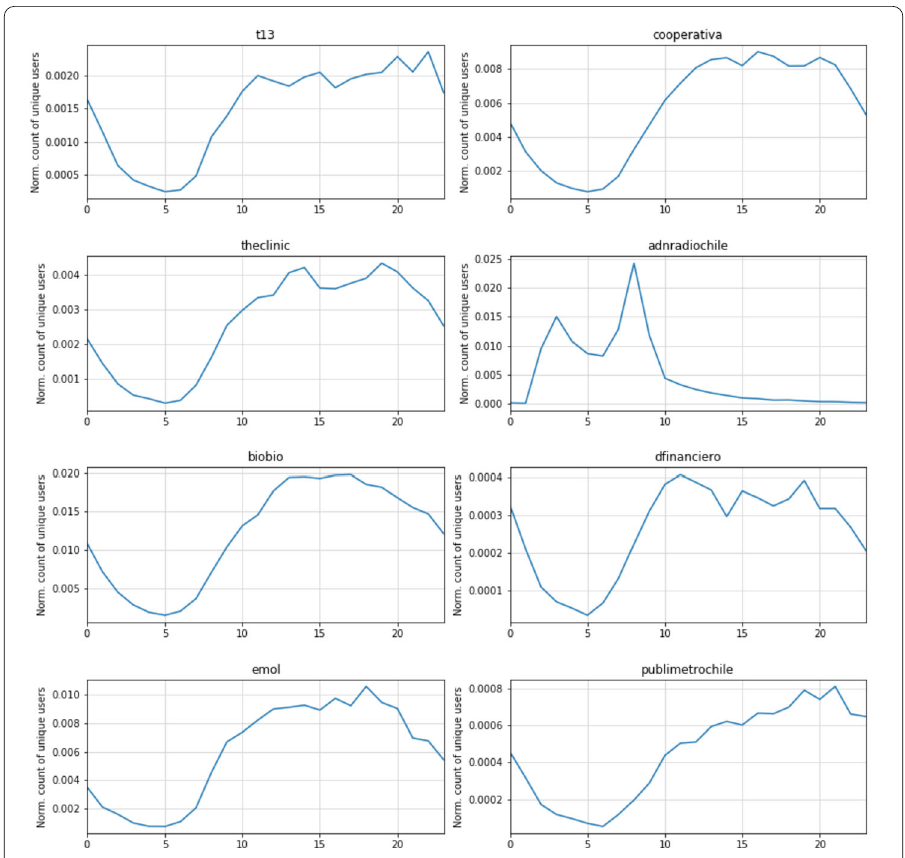
Figure 8 Unique users over the whole time window studied, detailed by hour and by news outlet. On the horizontal axis we have the time of the day, and on the vertical axis the normalized accesses. From these